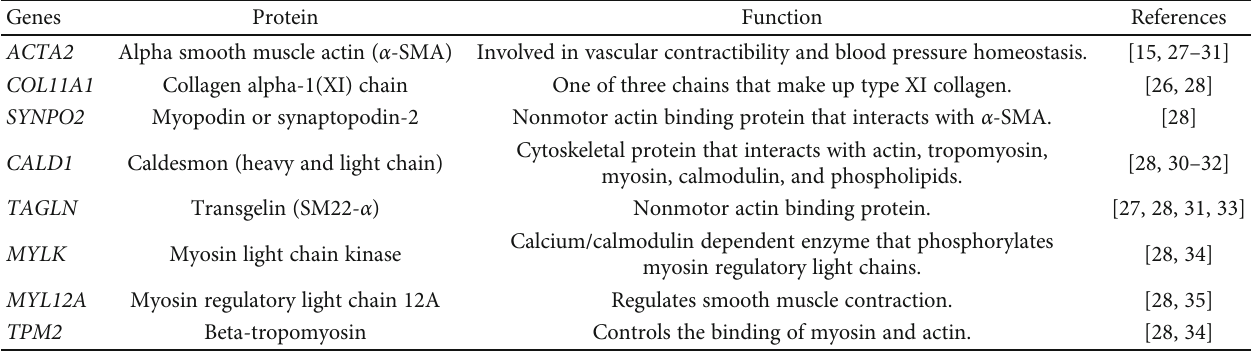
Table 1: Statistically signi fi cant ( α ≤ 0 : 01 ) DEGs identi fi ed in cluster 1 that encode for proteins that play a role in contractile cells.